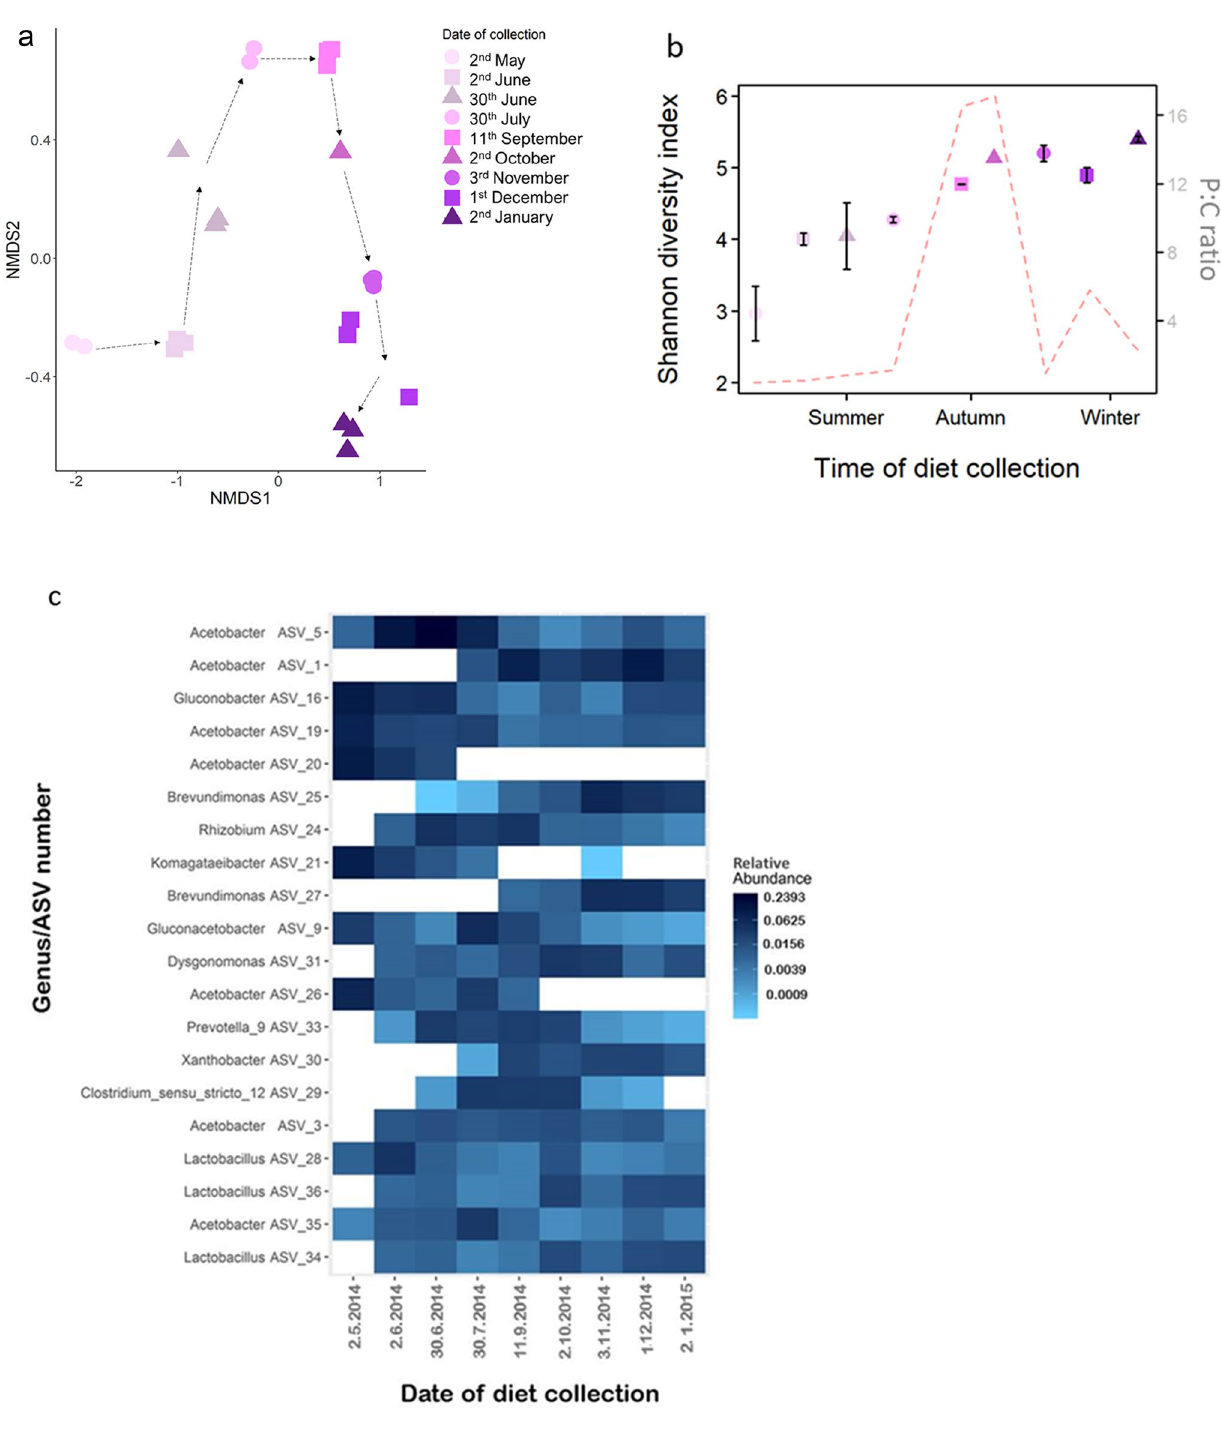
Figure 1. Nutritional composition and microbial community structure of the natural diets ( n = 1–3). ( a ) Two- dimensional nonmetric multidimensional scaling (NMDS) axes based on Bray–Curtis dissimilarity matrices of amplicon sequence variants (ASVs). Each point represents the microbial community in a replicate. Dotted arrows inserted for easy interpretation of associations with date of collection. ( b ) Shannon diversity index (left y-axis) of the microbial community of the diet samples across the collection dates. Points show mean (± 95% CI). Colour and symbol code same as ( a ). The red dotted line represents the protein to carbohydrate (P:C) ratio (right y-axis). ( c ) The 20 relatively most abundant ASVs across diet samples with relative abundance indicated by the colour coding. Figures ( a,b ) created using R package ggplot2 v3.3.3 (https:// ggplo t2. tidyv erse. org/). Figure ( b ) created using R package phyloseq v1.34.0 (https:// github. com/ joey7 11/ phylo